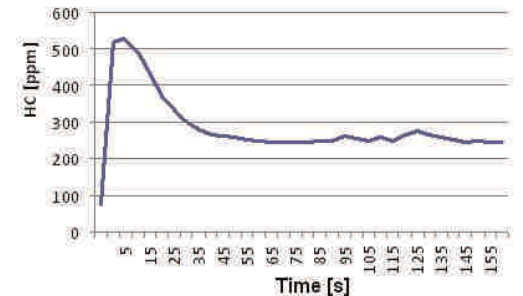
Fig. 5. Changes in the composition of hydrocarbons in the exhaust during warm-up phase for engine at idle